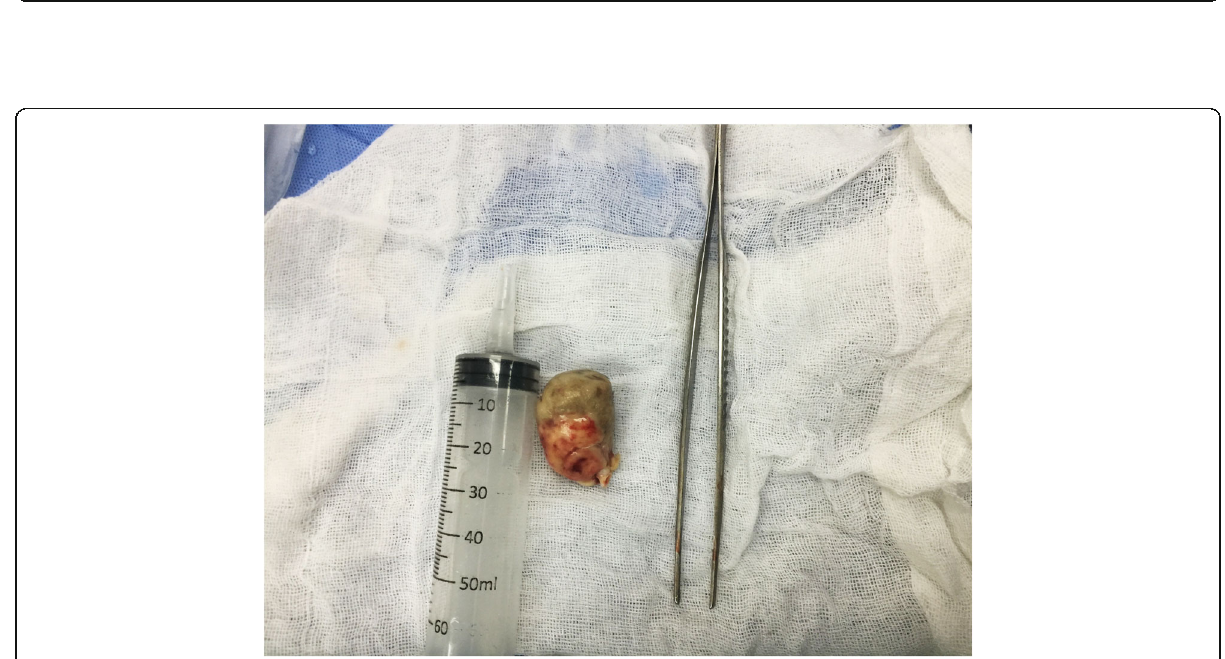
Fig. 3 Infantile right atrial myxoma. a The mass is observed attached to the IAS and excised with a free margin of the IAS and the right atrial wall. b Specimen after excision showing a mass of size 4 ×2 cm. c The defect in the IAS. D Reconstruction of the IAS using autologous pericardium and closure of the right atrial wall